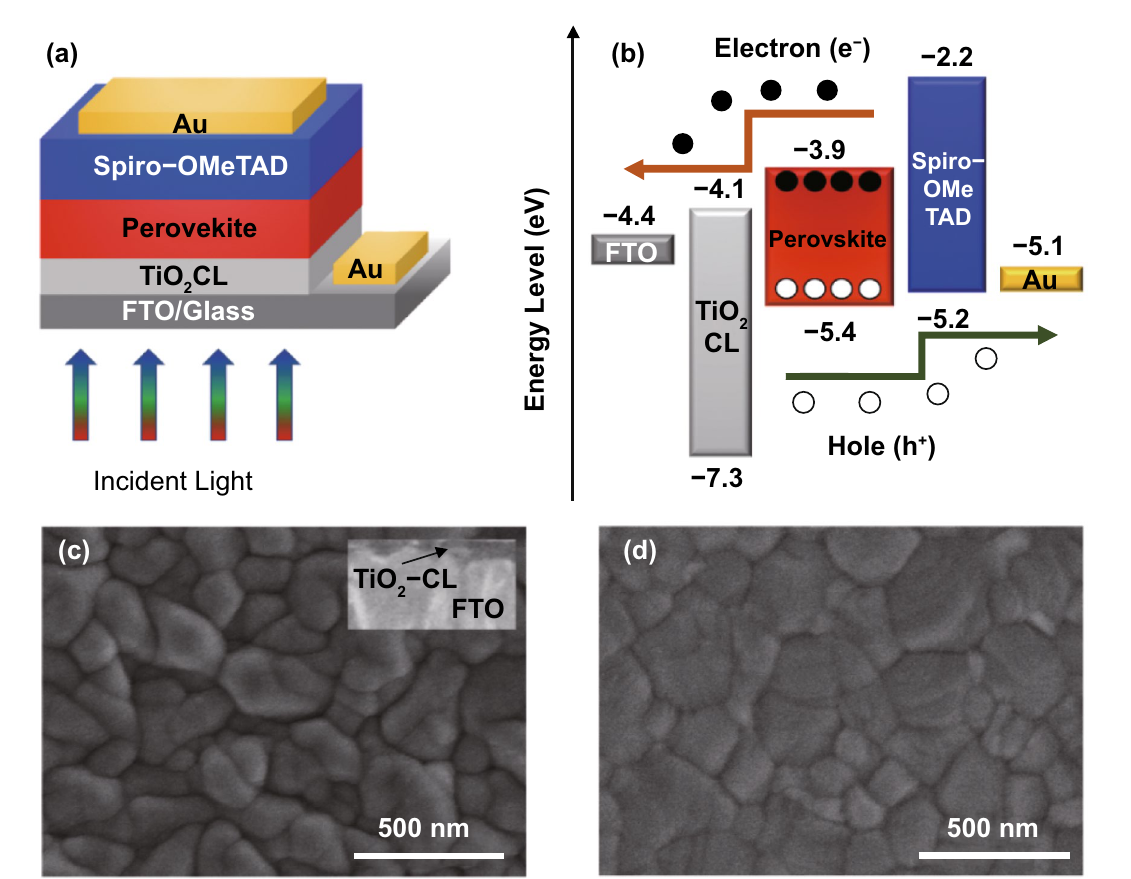
Fig. 1 a Schematic diagram and b corresponding energy levels of the investigated single‑junction planar perovskite solar cell. Top‑view SEM micrographs of c spray pyrolysis deposited TiO 2 compact layer (the inset shows the cross‑sectional view of the TiO 2 ), and d perovskite film deposited on TiO 2 ‑CL/FTO substrate. The TiO 2 precursor solution has a concentration of 0.35 M and a thickness of 70